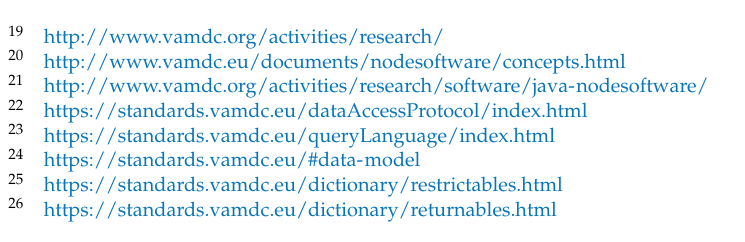
Figure 7. View of the history part when three citable versions are stored in the